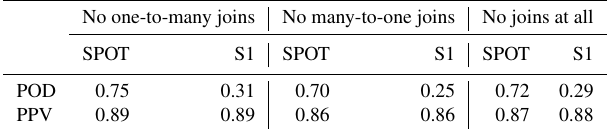
Table E1. POD and PPV for the SPOT and S1 mapping neglecting one-to-many, many-to-one or all joins (for the definition of those joins refer to Fig.